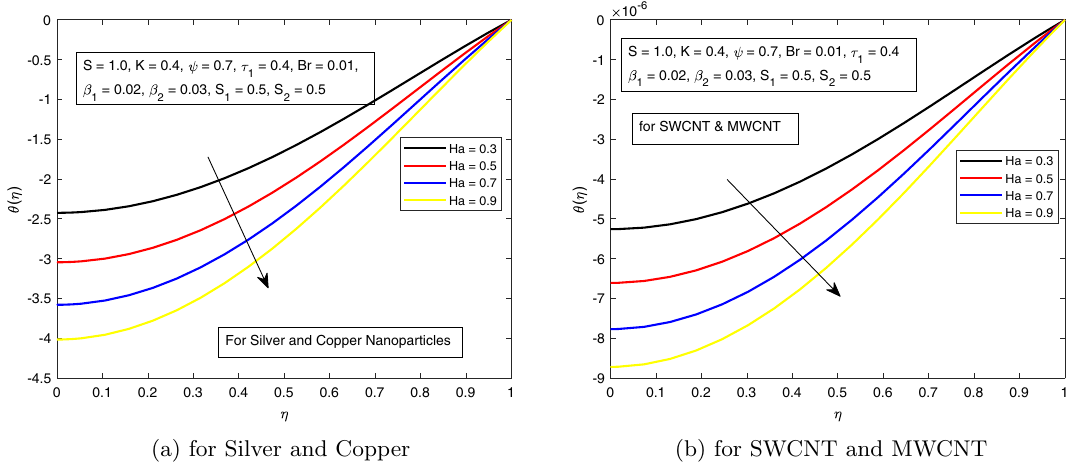
Figure 2. Influence of Ha on temperature distribution θ( r ) for the hybrid nanofluid combination of (a). Ag and Cu , (b) SWCNT and MWCNT .